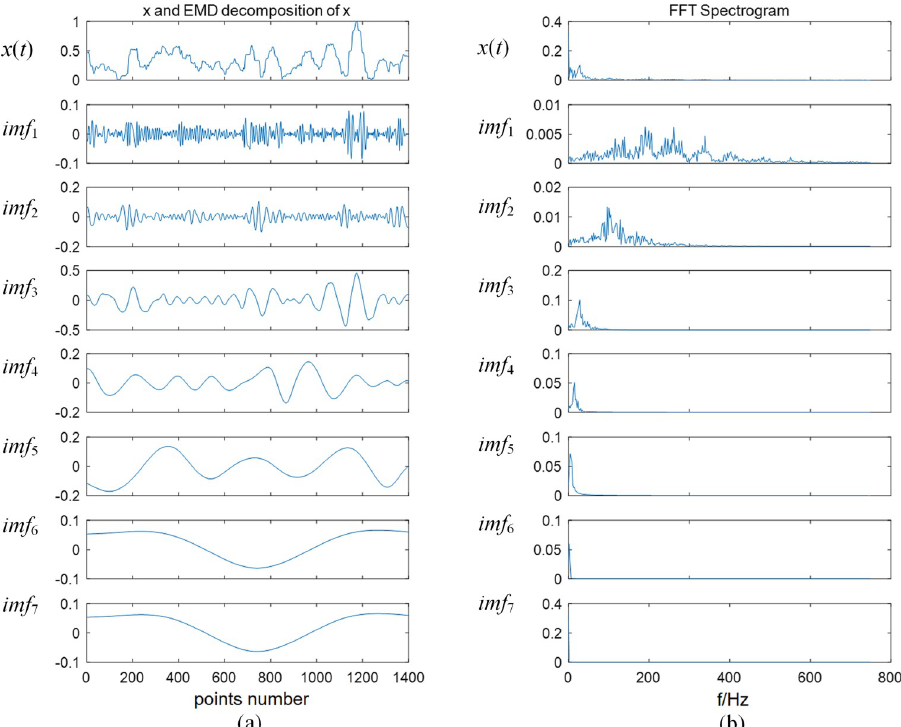
Fig 3. (a) Raw sEMG signal and its time-domain distribution diagram of a series of IMFs after EMD decomposition. (b) Frequency spectrum of raw sEMG signal and its series of IMFs’ frequency distribution diagrams obtained via decomposition after FFT computation.